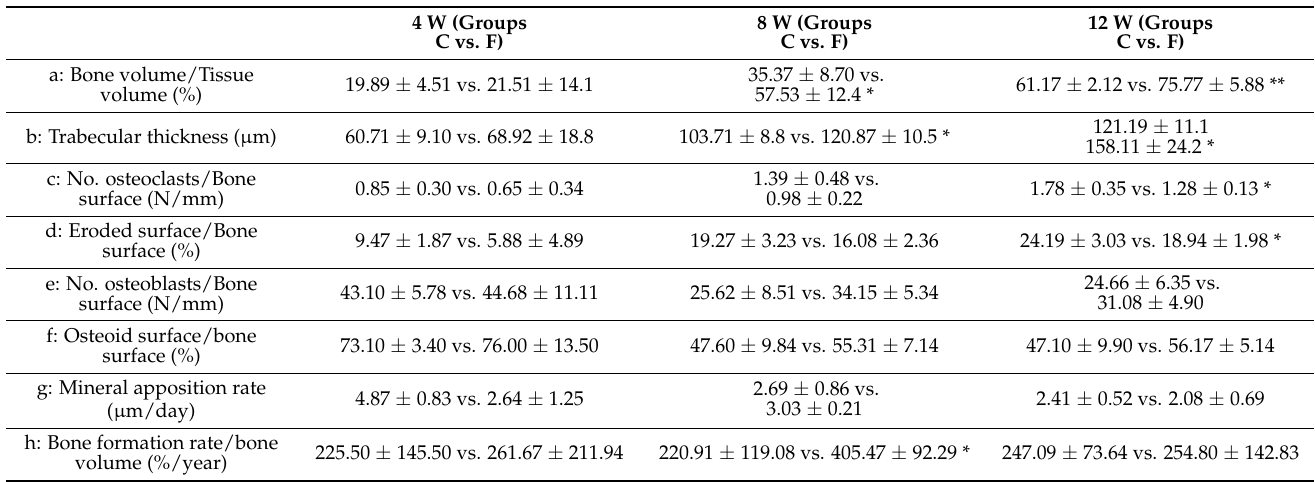
Table 1. Results of bone